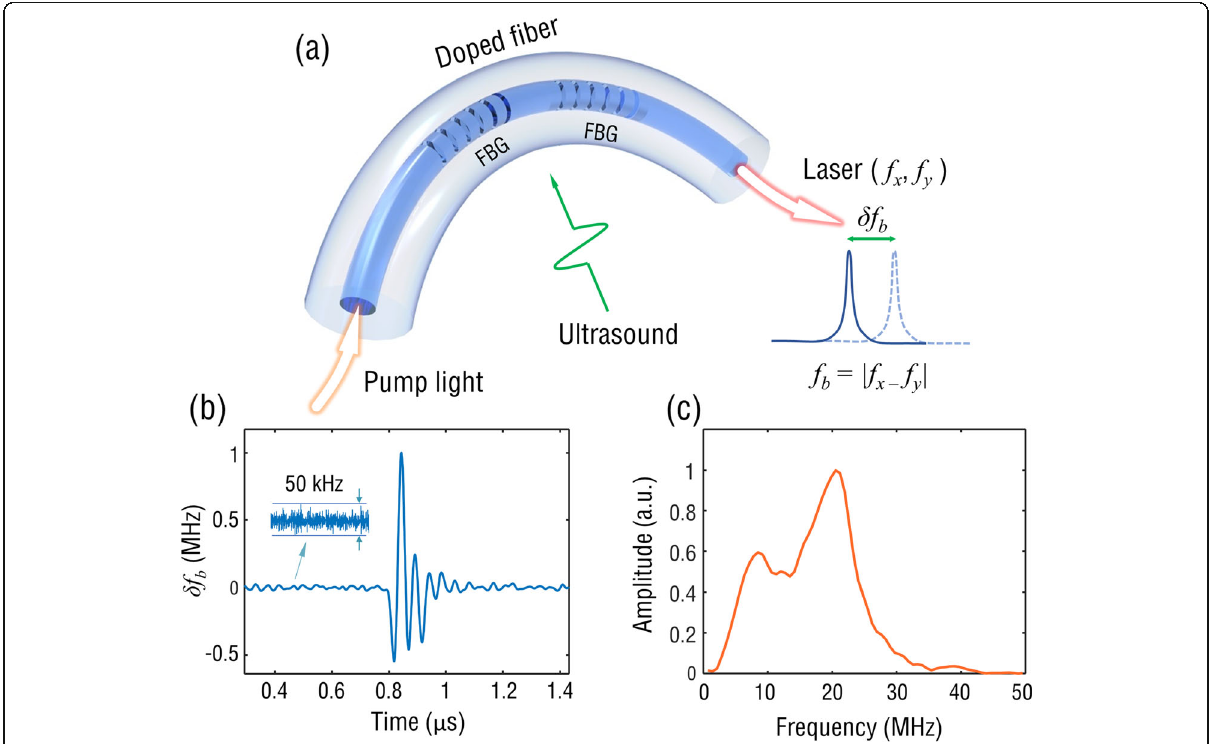
Fig. 2 a Work principle of fiber-laser ultrasound transducer. b Temporal response and c frequency response to an ultrasound